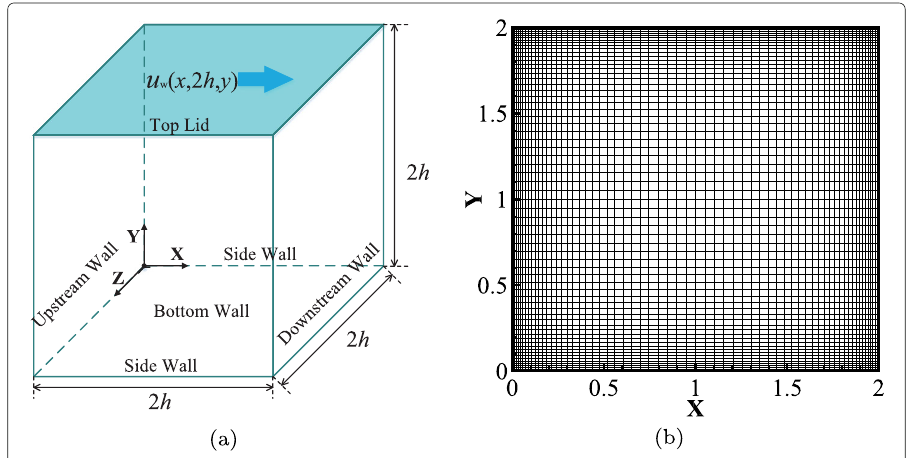
Fig. 15 a The flow domain and coordinate system of the lid-driven cubical cavity flow. b The grid on plane Z=1